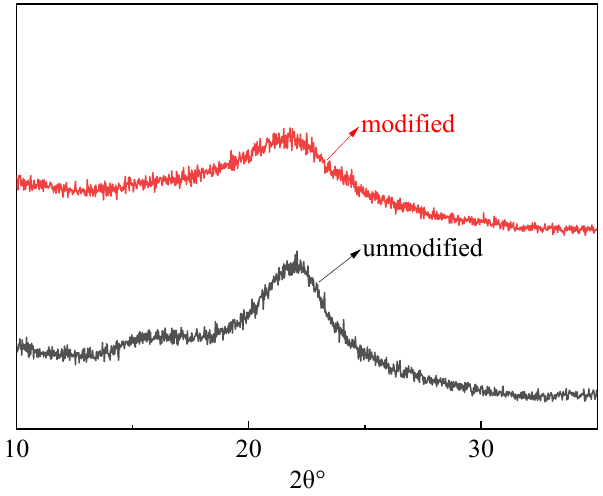
Figure 6. XRD pattern of rice straw, unmodified and modified.